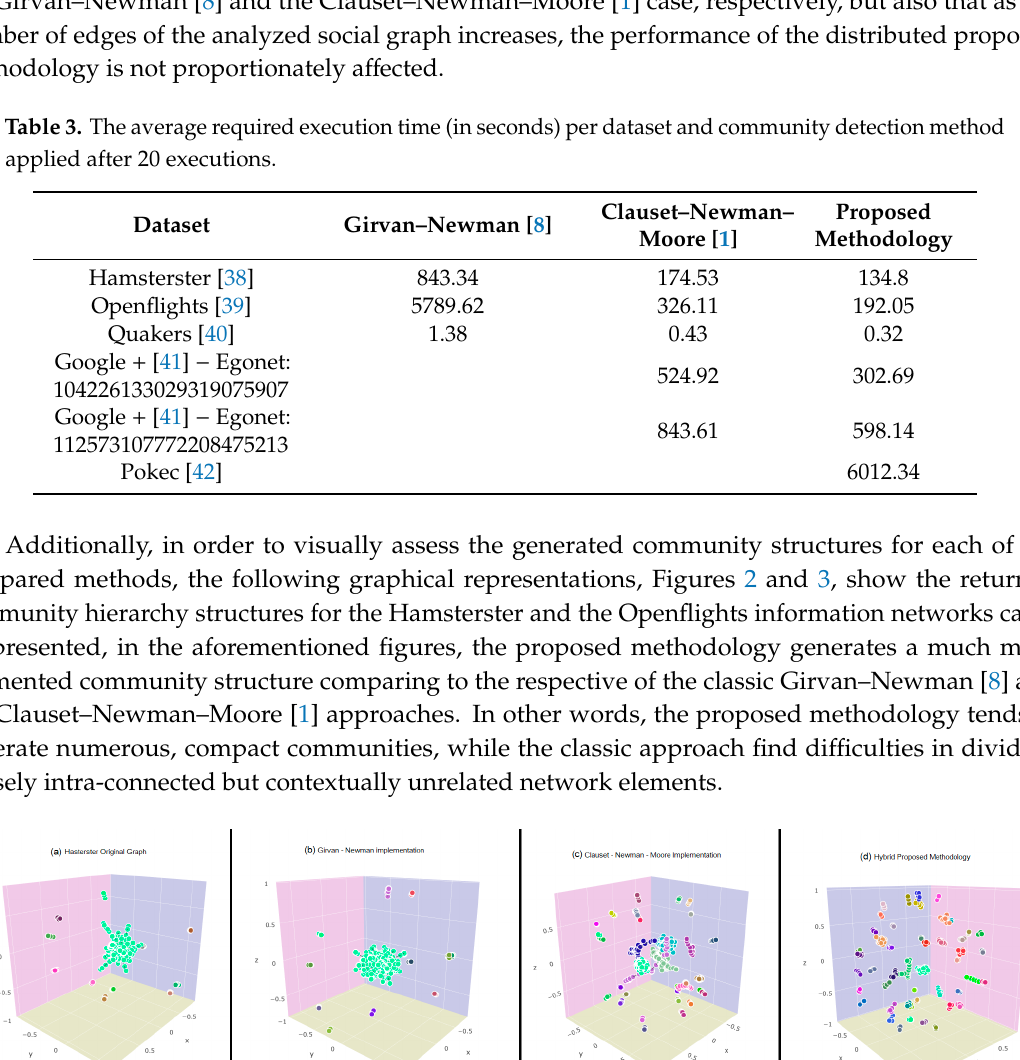
Table 2. The proposed methodology best execution arguments.